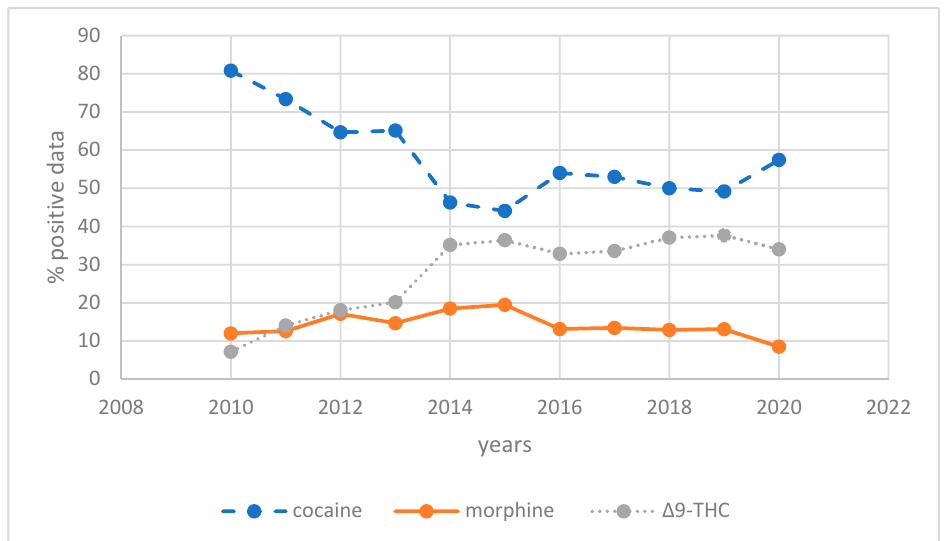
Figure 1. Drugs/year distribution of monodrug users’ group (MDU).